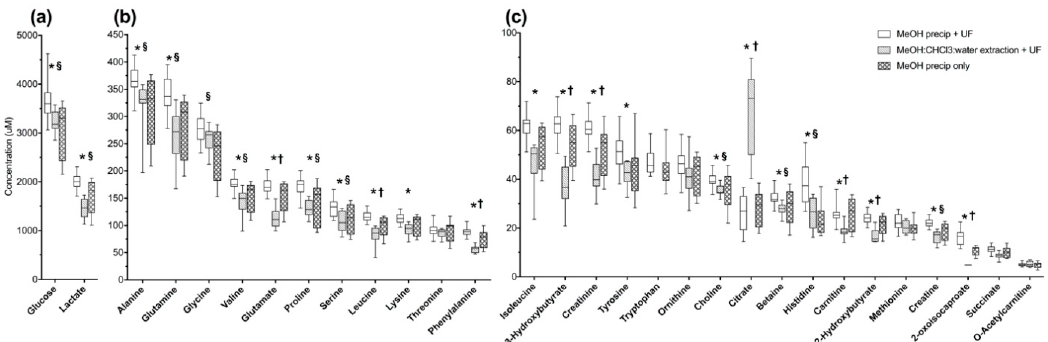
Figure 1. Macromolecule removal method influences measured metabolite concentrations in human serum. Pooled human serum technical replicate samples from healthy individuals subjected to either